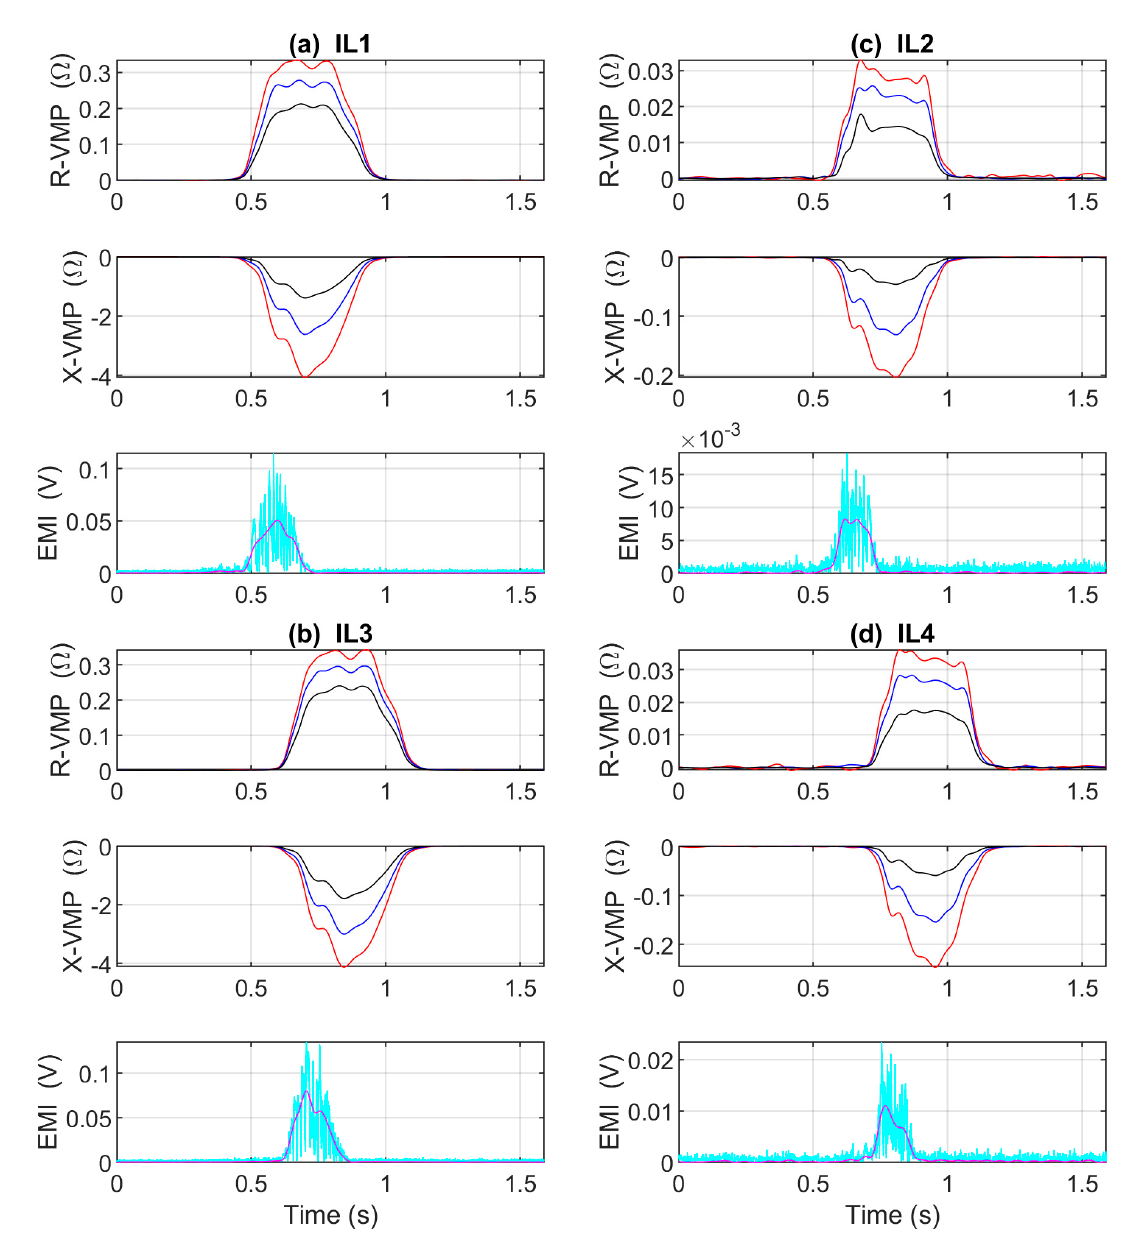
Figure A3. VMPs and EMIs of Hyundai i30 after denoising process and low-pass filter with the flat-top pass-band adjusted to the vehicle velocity. The rest of the description is the same as in Figure 2.